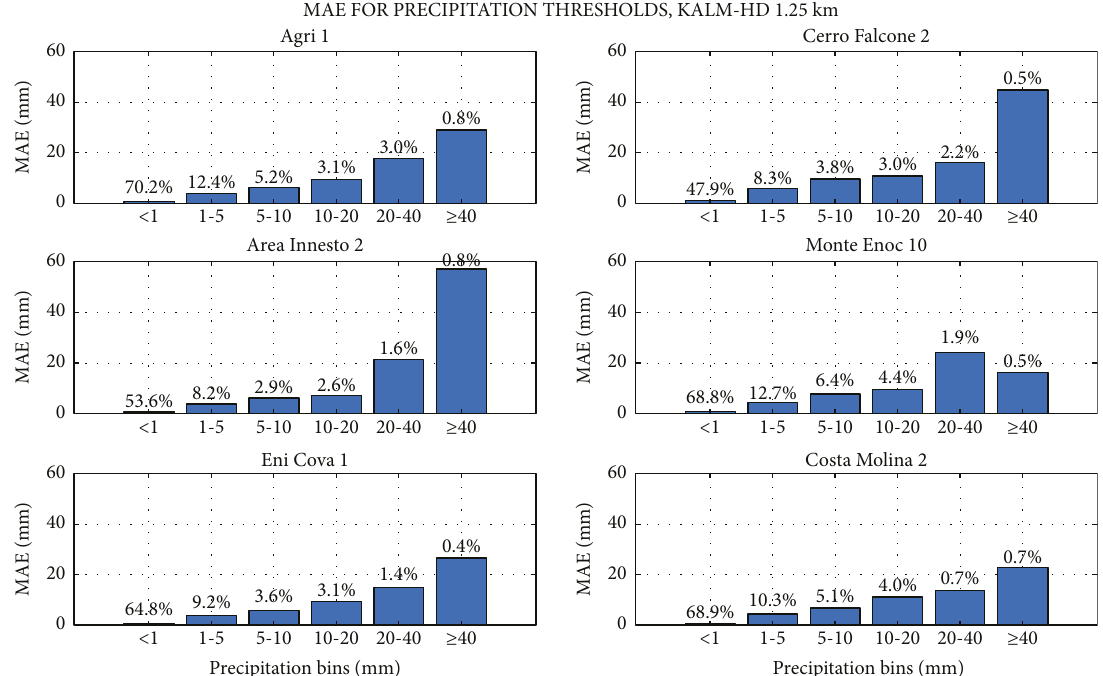
Figure 10: Mean absolute errors for precipitation thresholds in the two years of the observation period over the six weather stations at day +1 as lead time for the KALM-HD model with 1.25km. Values in red are referred to as the percentage of analyzed events in each bin.